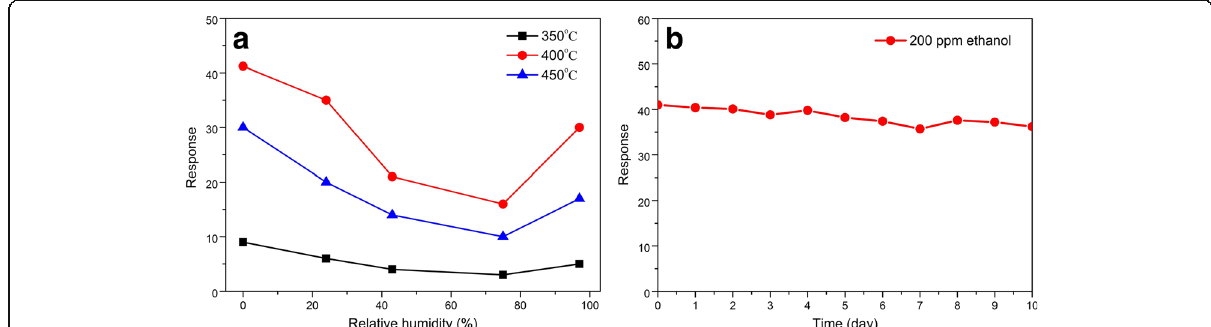
Fig. 7 a Response of the mesoporous SnO 2 sensors to 200 ppm of ethanol as a function of the relative humidity at 200 °C. b Long-term stability of the SnO